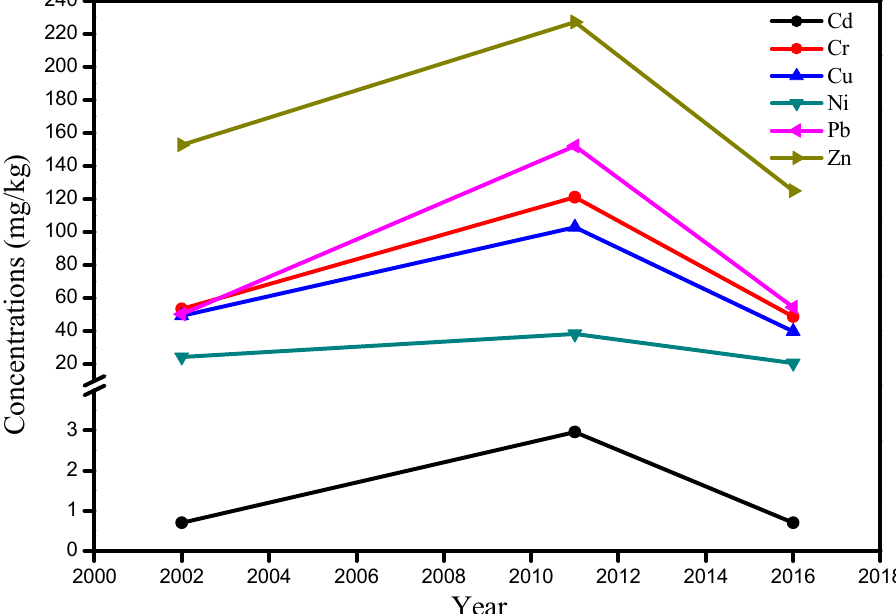
Figure 4. Temporal trend for metal concentrations in sediments of Shantou Bay.